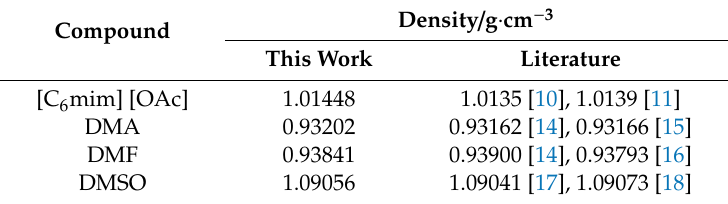
Table 2. Densities of pure compounds at 303.15 K and atmospheric pressure (0.0967 ± 0.002